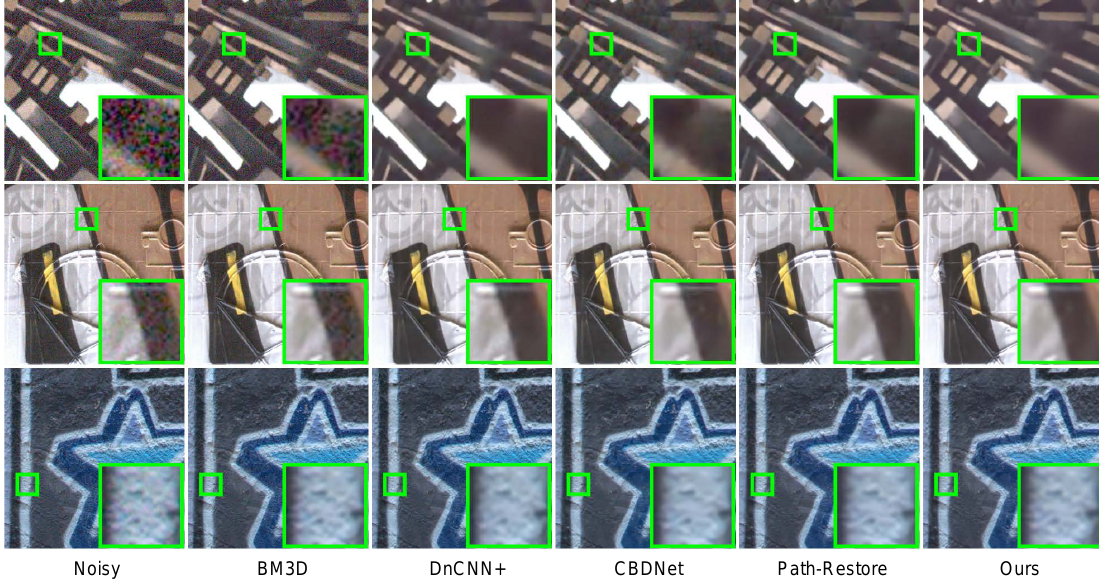
Figure 4. Qualitative results of real-world denoising on the Darmstadt Noise Dataset.